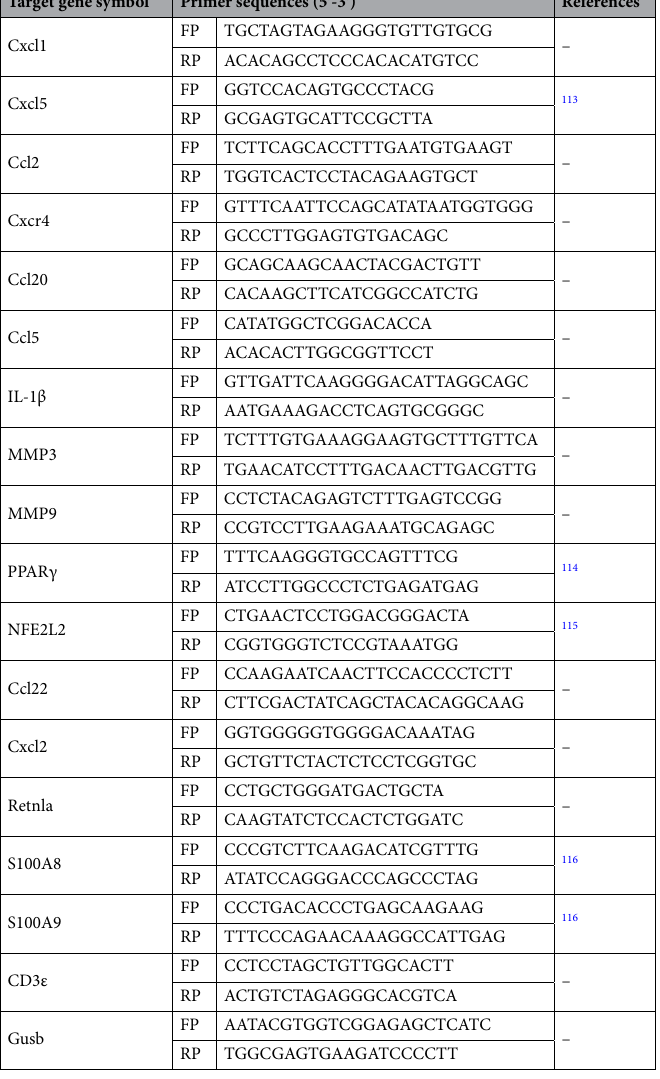
Table 1. Primers sequences for